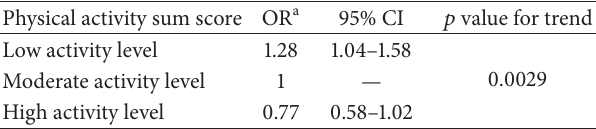
Table 4: Adjusted odds ratios for a more complicated delivery, that is, emergency C-section (versus any vaginal delivery) or emergency C-section and vacuum extractor (versus spontaneous vaginal delivery) according to a physical activity sum score covering the time period from one year before pregnancy and all three pregnancy trimesters. The Danish Dystocia Study. 𝑁 = 2435